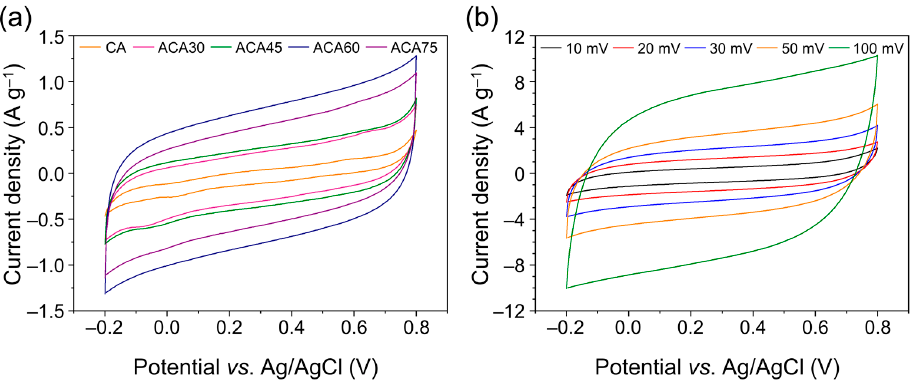
Figure 5. ( a ) CV curves of CA and ACA electrodes collected at a scan rate of 10 mV s − 1 and ( b ) CV curves of ACA60 electrode at different scan rates.